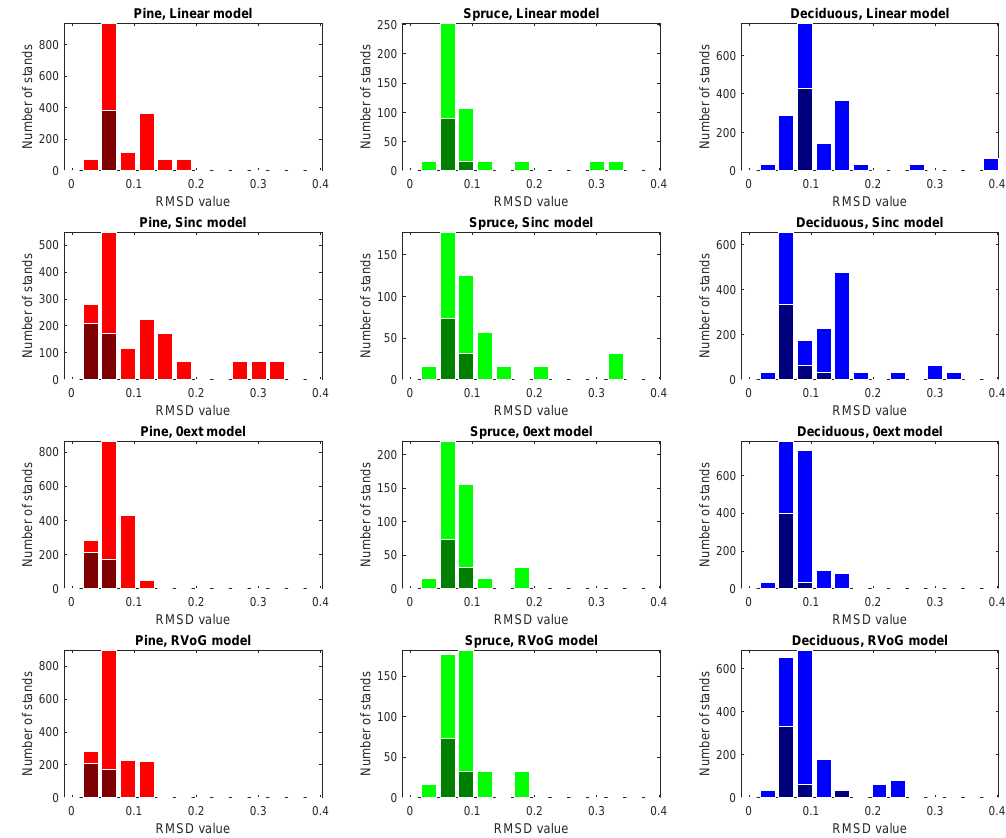
Figure 6. Goodness of fit for the four models: linear (13), sinc (14), 0ext (15) and RVoG (3) and for three different forest types. On the histogram x-axis is the Root Mean Square Difference (RMSD) between measured coherence magnitude and model predicted coherence. Models use ALS-measured forest stand height as an argument. The darker bars depict the same histograms for a subset of scenes with HoA approximately twice as large as the highest stand height (4 January 2011, 3 March 2012, 8 March 2012, 14 March 2012 and 25 March